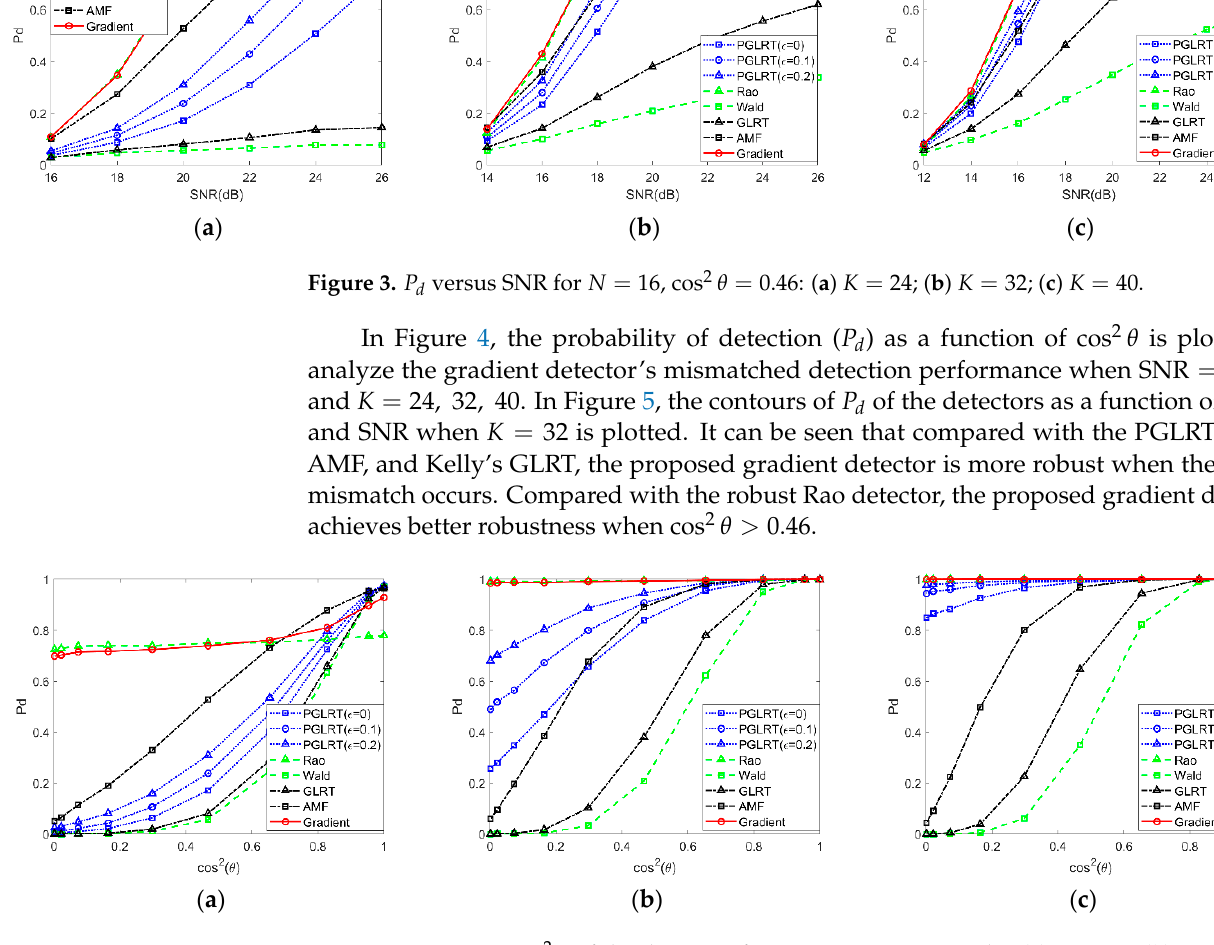
Figure 4. P versus Figure 4. P d versus cos 2 θ of the detectors for N = 16, SNR = 20 dB: ( a ) K = 24; ( b ) K = 32; ( c ) d K =